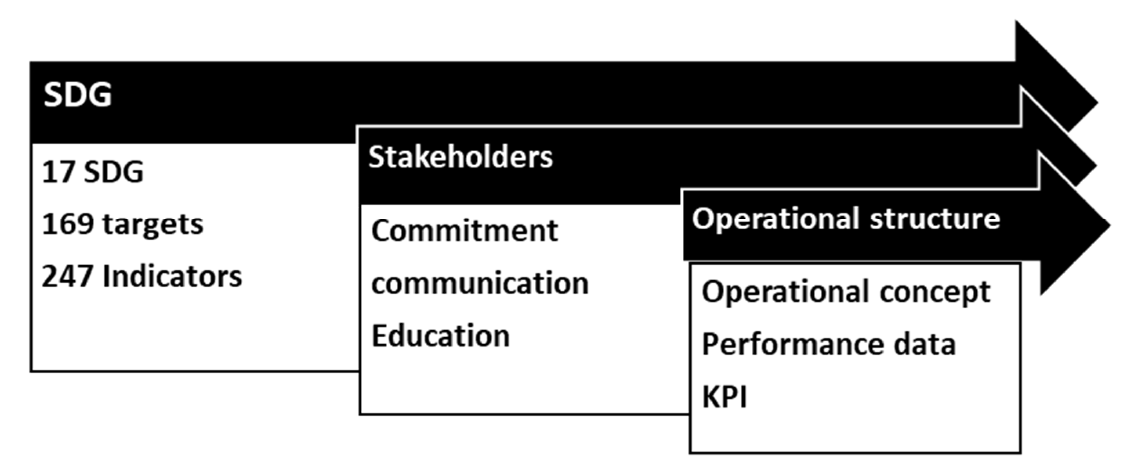
Figure 2. Conceptual scheme for SDG integration into value chains.